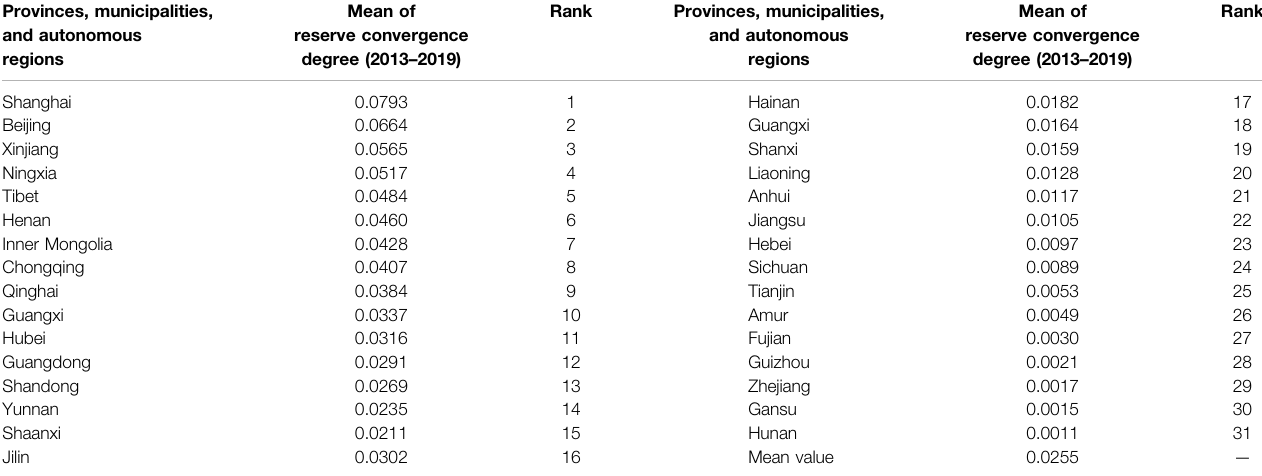
Data source: China Input-Output Table 2012, 2015, and